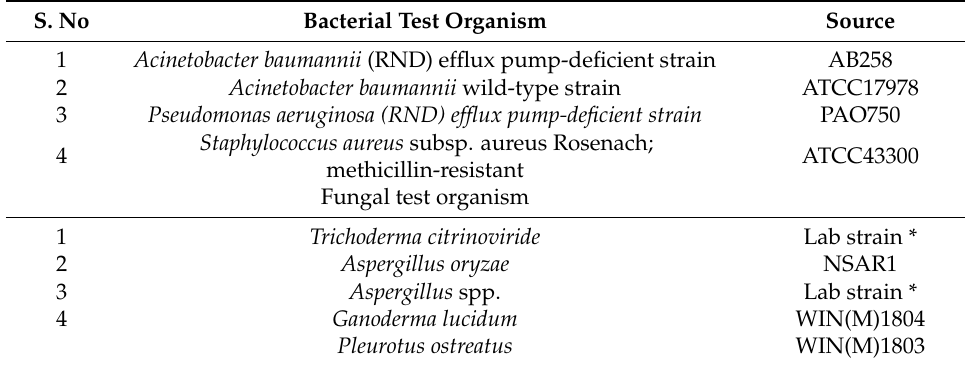
Table 1. List of test organisms used for antimicrobial